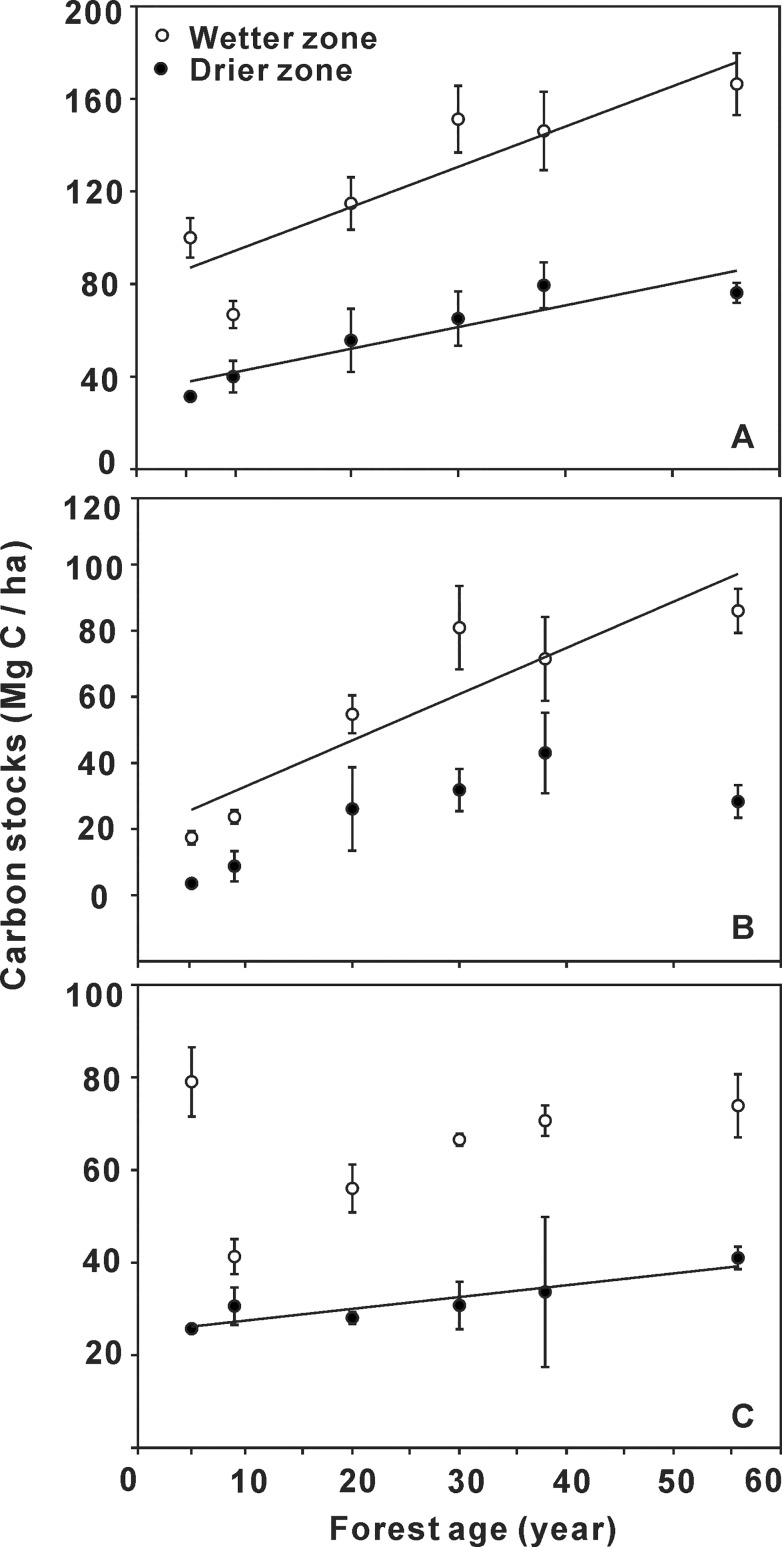
Carbon stocks in ecosystem (A), tree biomass (B), and forest soil (C) of black locust plantations across the chronosequence in drier zone and wetter zone of the Loess Plateau.Linear regression relationship between C stock and forest age was: (A) ecosystem, y = 78.39 + 1.74 x (R2 = 0.79, P = 0.017) in wetter zone and y = 33.28 + 0.94 x (R2 = 0.85, P = 0.008) in drier zone, respectively; (B) tree biomass, y = 18.86 + 1.40 x (R2 = 0.83, P = 0.011) in wetter zone; (C) forest soil, y = 24.90 + 0.26 x (R2 = 0.84, P = 0.010) in drier zone. Values are represented by mean ± standard deviation and the duplicates are 3 in drier zone and 5 in wetter zone, respectively. Significance level was determined at P ≤ 0.05.